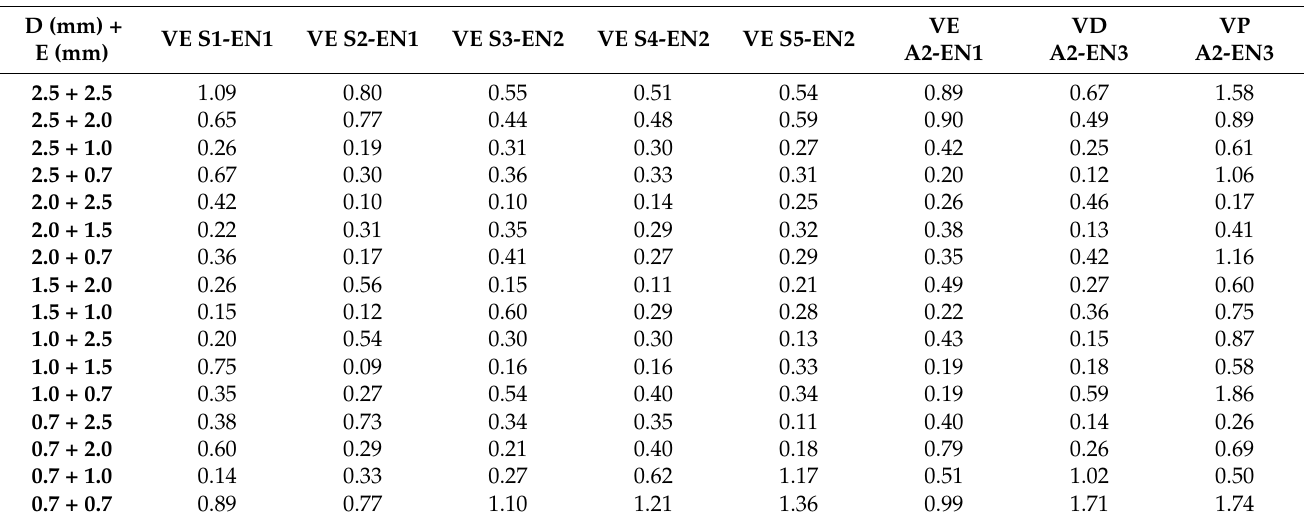
Table 3. ∆ E 00 color differences between measured and predicted CIE-L*a*b* values for all layered samples tested in our